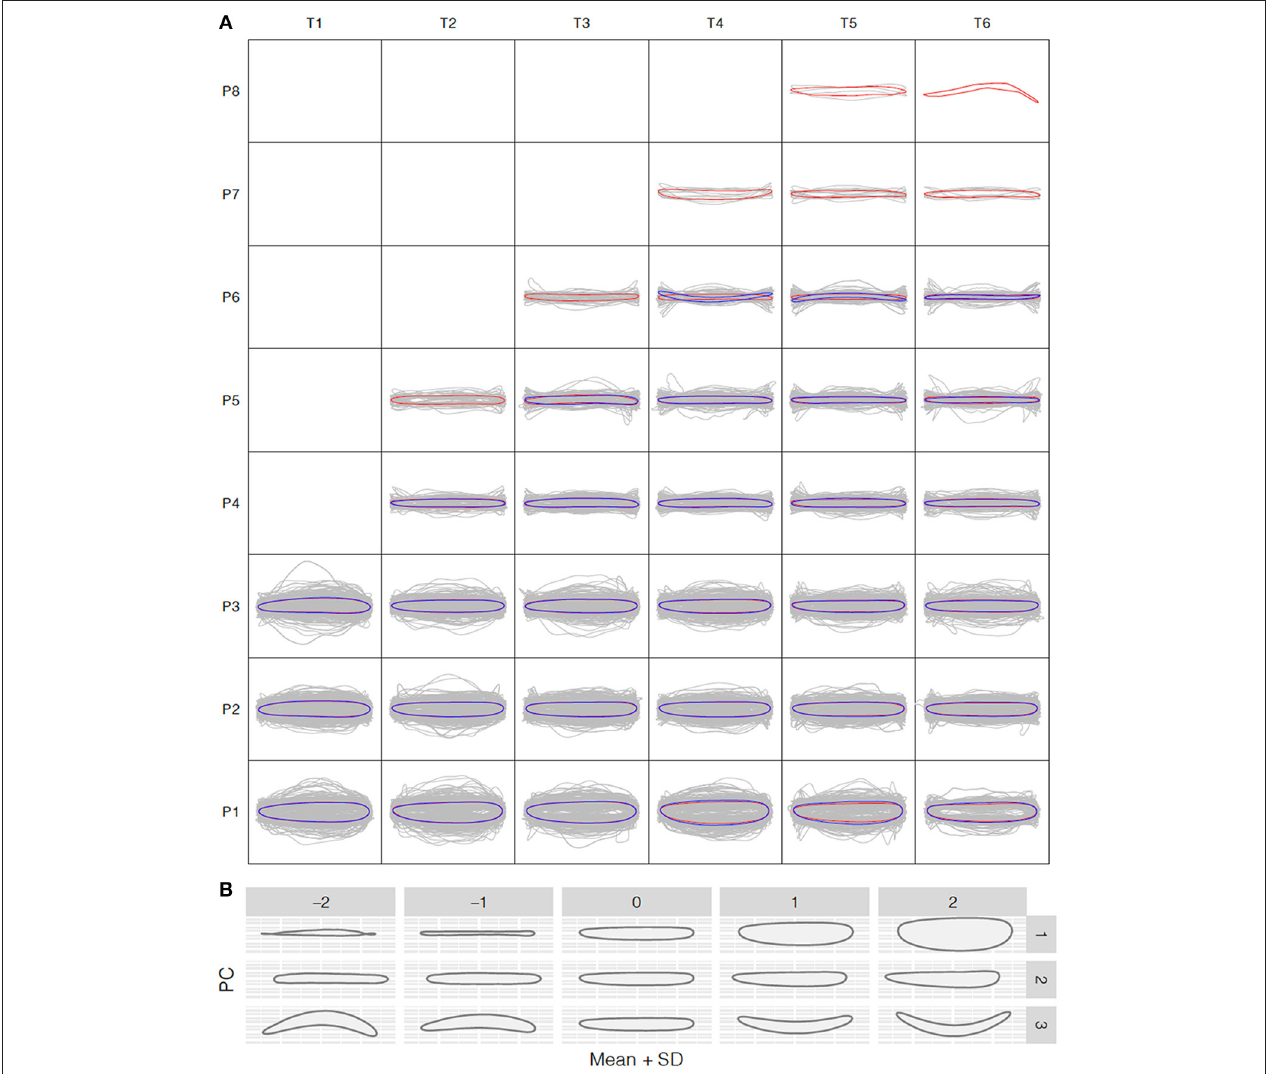
FIGURE 3 | Shape variation analysis along the P. euphratica shoot axis. (A) Normalized shape profiles under control and salt stress conditions at T1–T6 (20-days intervals) and leaf positions P1–P8 (from bottom to top), controlled for size effects. Gray lines indicate the individual leaf shapes; red and blue contours indicate the average shapes calculated at each time and position for the control and salt stress groups, respectively. (B) Principal component analysis (PCA) of leaf shape. PC1–PC3 are the top PCs, cumulatively explaining 42.18, 72.56, and 93.41% of the total leaf shape variation in terms of the length/width ratio, lamina base shape, and shape curvature,